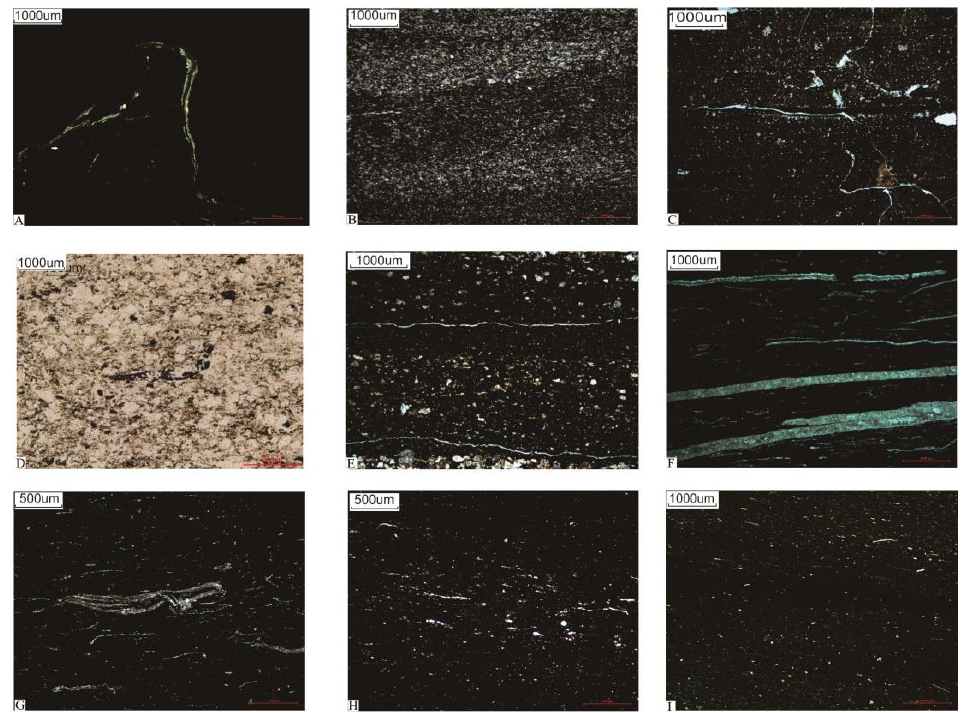
Figure 2. Microscopic image of the shale of the Wujiaping Formation. ( A ) Development of argillaceous and organic matter, 4366.17 m; ( B ) quartz debris, 4368.74 m; ( C ) alternating distribution of bright–dark laminae, 4364.00 m; ( D ) plant debris, 4365.92 m; ( E ) fine sandstone mixed with silty mudstone, 4364.93 m; ( F ) massive development of horizontal laminae, 4332.50 m; ( G ) double-shell debris, 4331.73 m; ( H ) layer alignment of radiolarian and bone spicule, 4334.30 m; ( I ) layer distribution of bioclast, 4337.40 m.